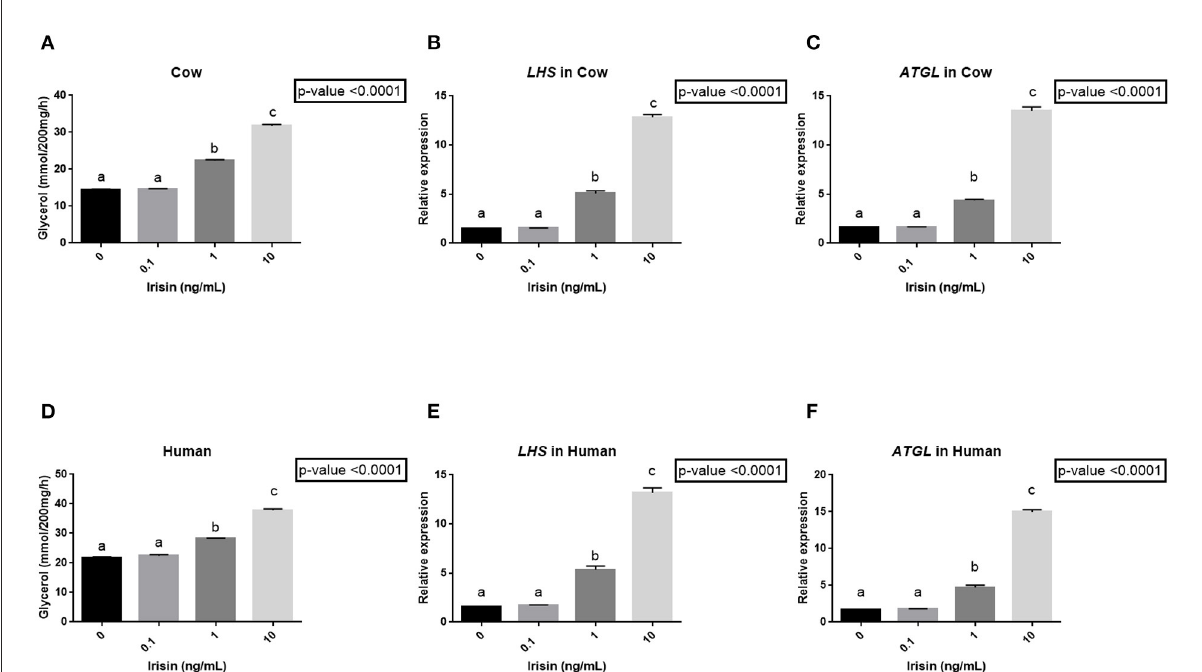
FIGURE7 Effect of human recombinant irisin on the release of glycerol and on HSL and ATGL mRNA abundance from bovine (A–C) and human adipose tissue explants [ (D–F) , n = 6 for each species]. (A,D) Data are expressed as millimoles per 200mg of tissue per hour ± SEM and different letters indicate significant difference at p < 0.0001. (B,E) ATGL mRNA and (C,F) HSL mRNA abundance in adipose tissue explants incubated with increasing doses of human recombinant irisin (0; 0.1; 1 and 10ng/ml; n = 6). Abundance is expressed relative to the geometric mean of 3 reference genes [ Cyclophilin A ( PPIA ), GAPDH and β -actin ] and analyzed by one way analysis of variance (ANOVA). Data are presented as mean ± SEM. Different letters indicate significant differences at p <